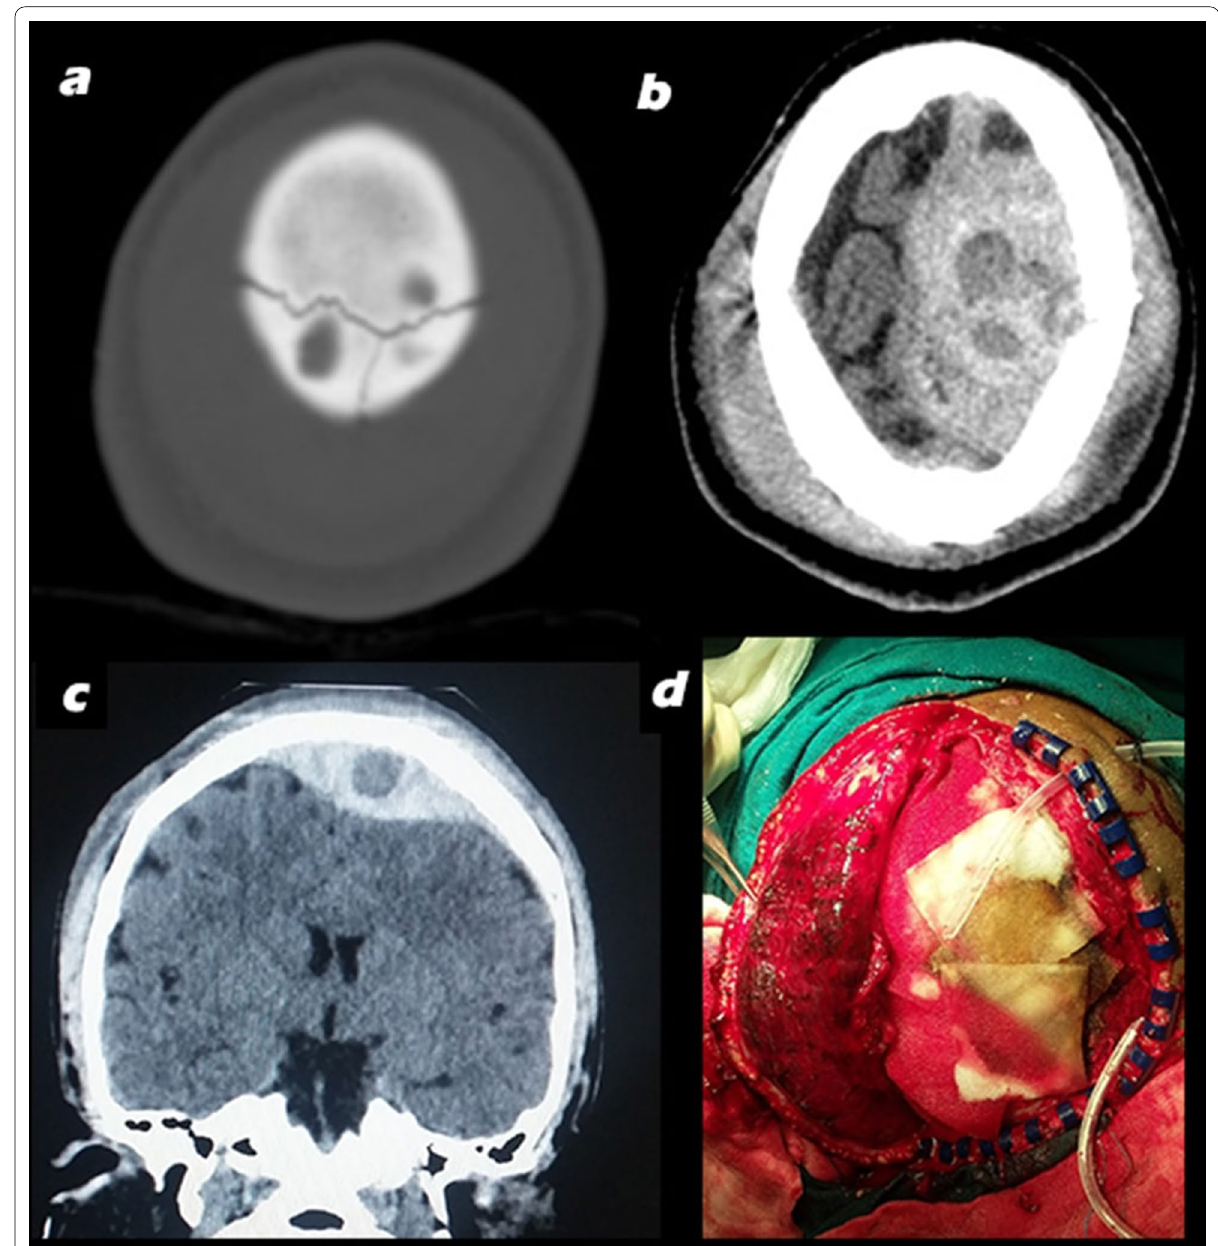
Fig. 4 a Diastasis of coronal suture; b extradural hematoma from midline; c coronal reformat of CT showing hematoma crossing midline to right and swirl sign near midline suggestive of active bleeding; d bleeding controlled by Gelfoam soaked with thrombin–gelatin hemostatic